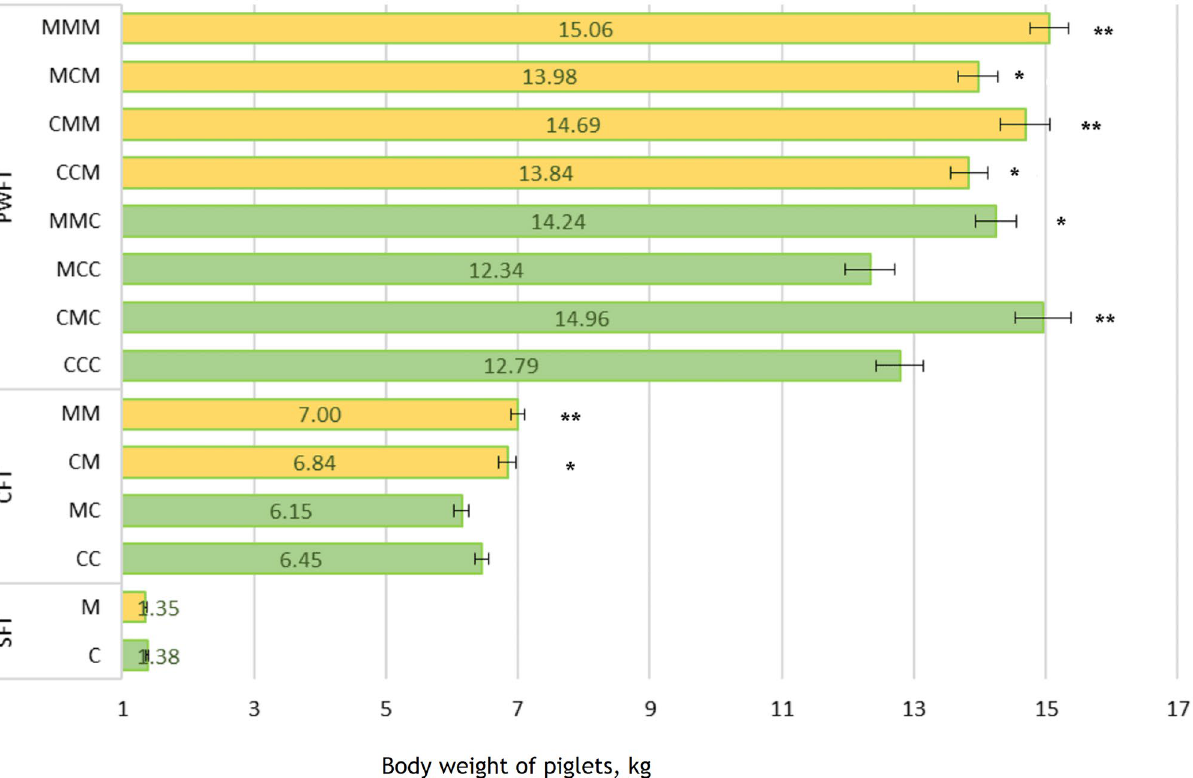
Figure 1. Body weights of piglets at different ages. MFC Sows fed micro-fibrillated cellulose; MM sow MFC, piglets fed MFC creep feed; MC sow MFC, piglets fed control creep feed; CM sow control, piglets fed MFC creep feeding; CC sow control, piglets fed control creep feed. C Control feed of sows; M MFC feed of sows; SFT Sow feeding treatment; CFT Creep feed treatment piglets; PWFT Post-weaning feed treatment piglets. MMM sow MFC, piglets fed MFC creep feed, post-weaning piglets MFC feeding; MMC sow MFC, piglets fed MFC creep feed, post-weaning piglets control feed; MCM sow MFC, piglets fed control creep feed, post-weaning MFC feed; MCC sow MFC, piglets fed control creep feed, post-weaning control feed; CMM sow control feed, piglets fed MFC creep feed, piglets post-weaning MFC feed; CMC sow control feed, piglets fed MFC creep feed; piglets post-weaning control feed; CCM sow control feed, piglets fed control creep feeding, piglets post-weaning MFC feed; CCC sow control feed, piglets fed control creep feed, piglets post-weaning control feed. *P < 0.05, and **P <